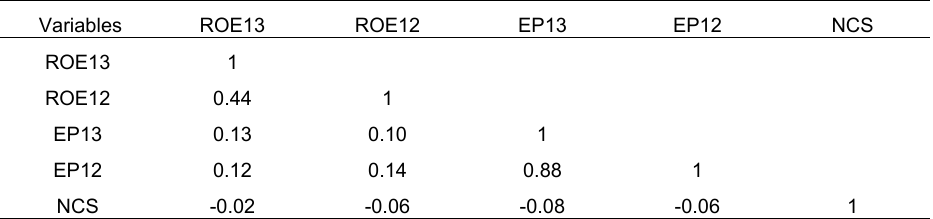
Table 4: Correlation of some variable with geography